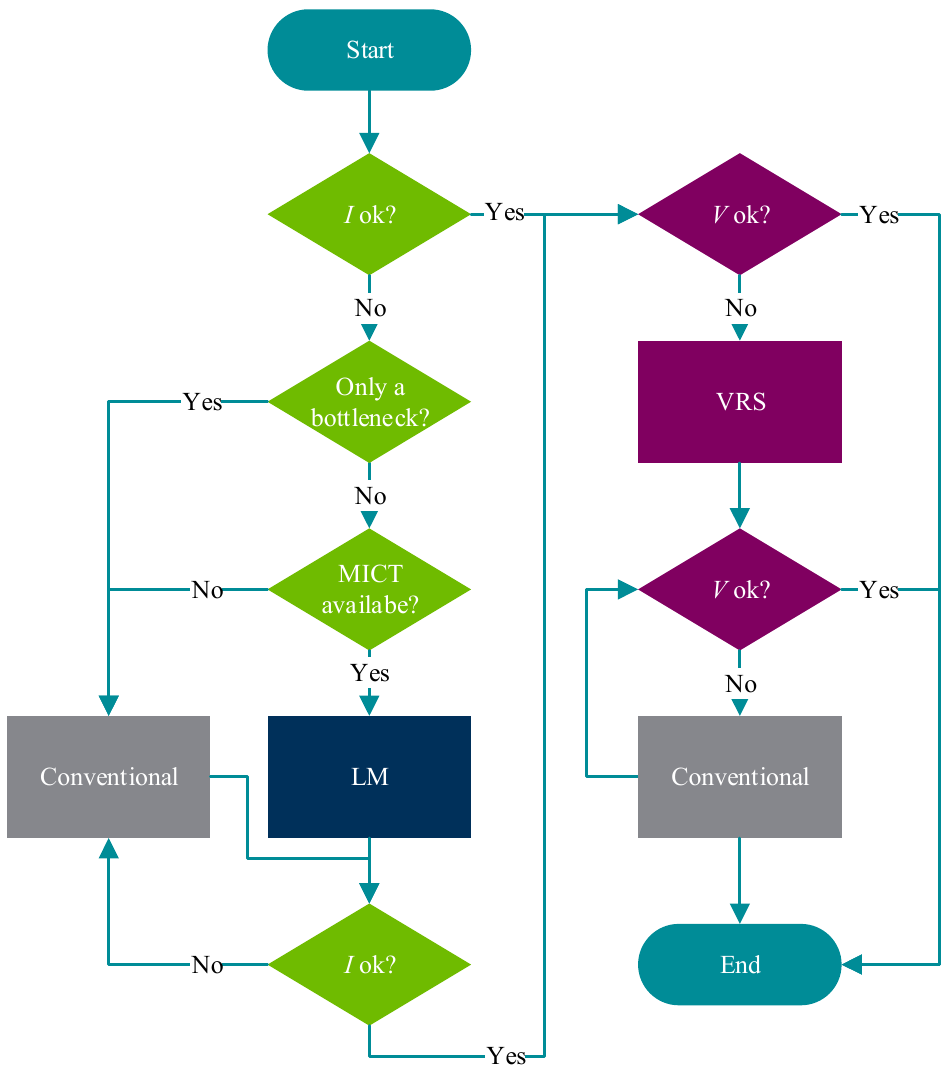
Figure 22. Flowchart for planning medium voltage grids.